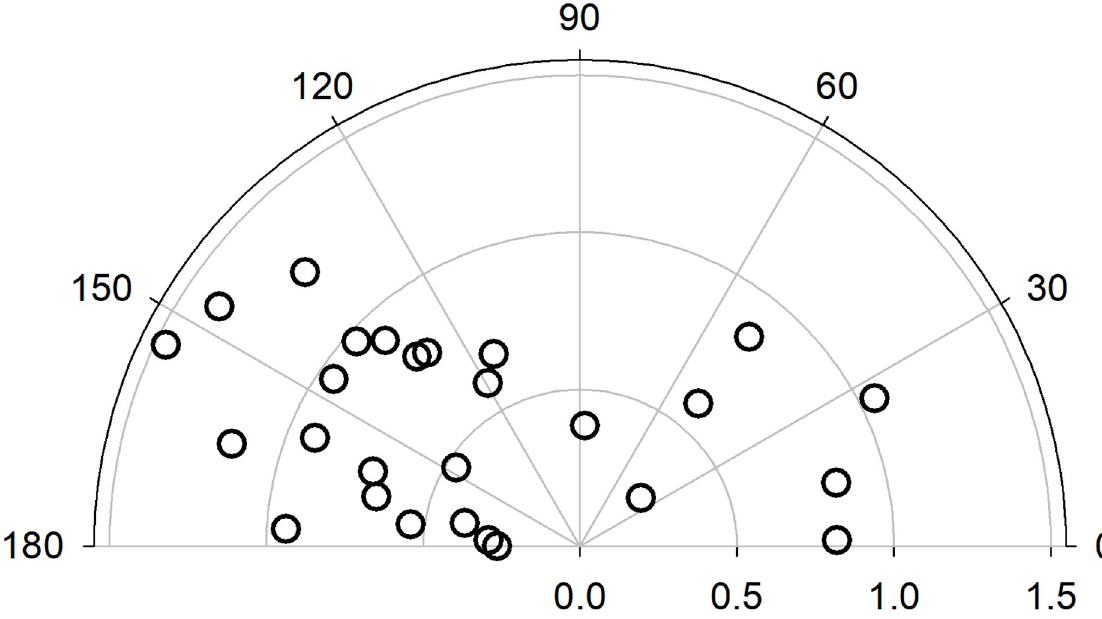
Fig 1. Polar values of 2-weeks post-surgery induced cylinder in